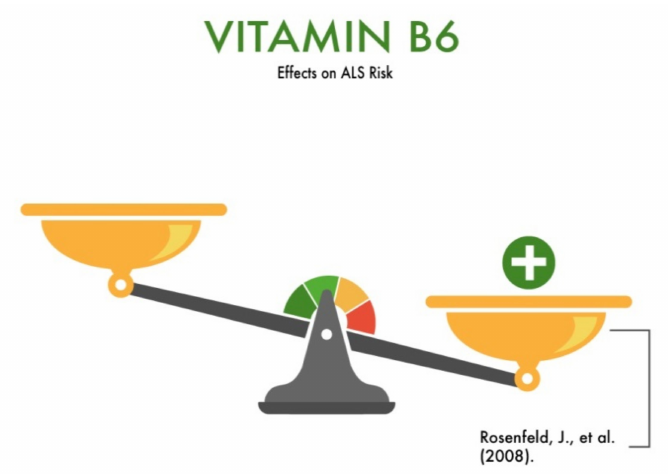
Figure 4. The effect of vitamin B6 on the risk of developing amyotrophic lateral sclerosis